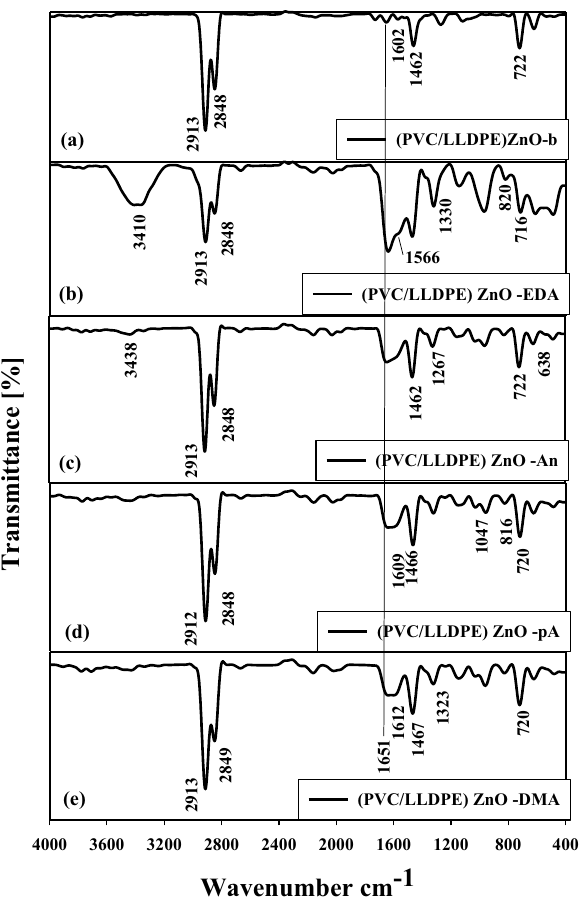
Figure 4. The FTIR/ATR curves for amined modified PVC in